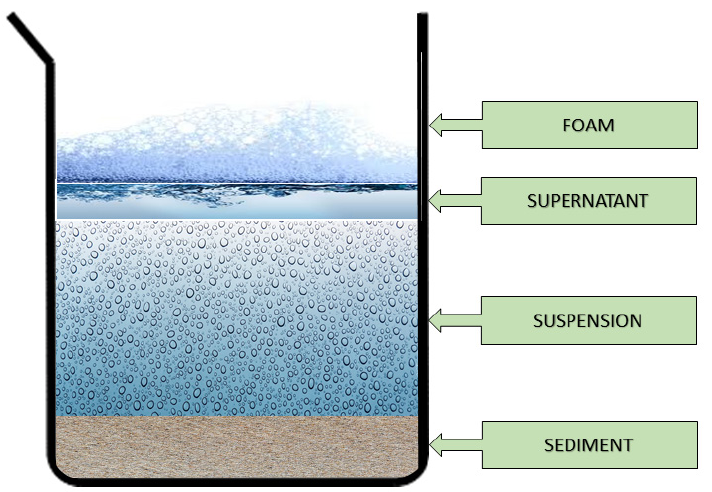
Figure 5. Layers that may appear in the fertilizer during longer storage, in the following order: sedimentation, a cloudy layer of suspension, a layer of clear liquid (supernatant) and a layer of permanent foam.